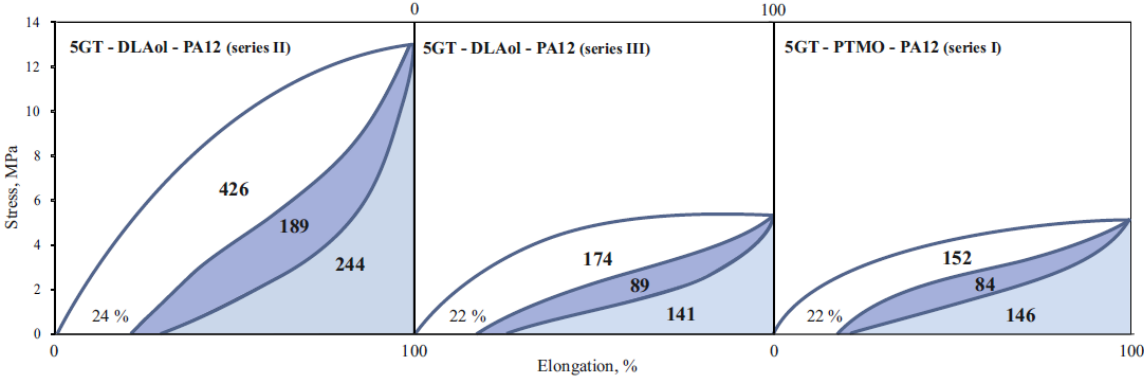
Figure 19. Mechanical hysteresis loops of the polymers 4, 9 and 14.